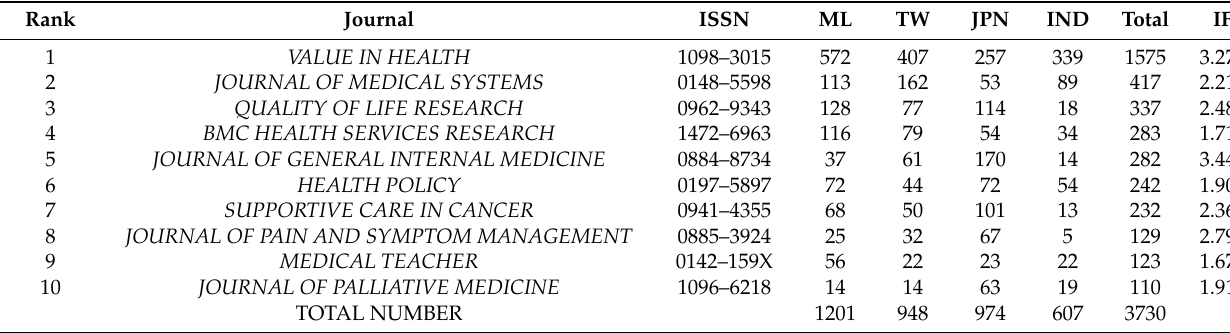
Table 3. Papers published in the top 10 popular health care sciences and services journals by researchers from Mainland China (ML), Japan (JPN), Taiwan (TW), and India (IND) (2007–2014).